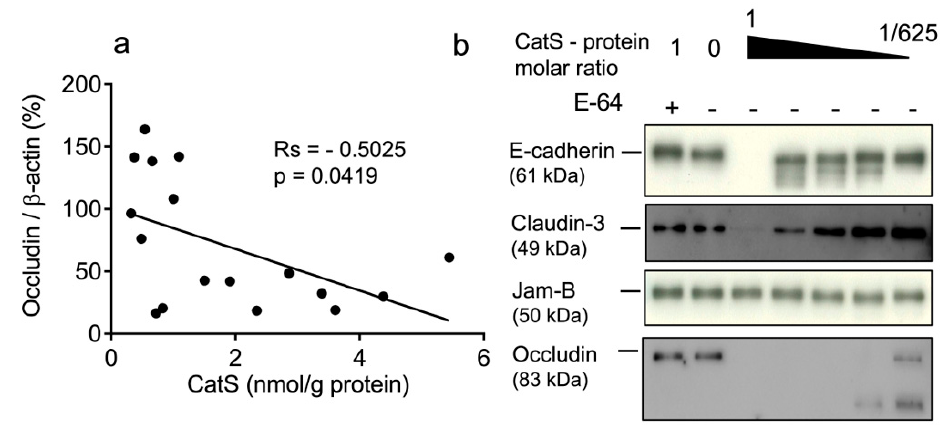
Figure 2. CatS activity negatively correlated with immunoreactive occludin level. ( a ): Correlation between CatS activity and occludin level in lung tissue lysates. Correlation was determined by linear regression and indicated by Spearman coefficient (Rs) and levels of significance ( p ). ( b ): in vitro hydrolysis of human recombinant E-cadherin, claudin-3, JAM-B, and occludin by CatS. Constant amount of junction proteins was incubated with CatS (molar ratio: 1:625 to 1:1) and incubated for 1 h at 37 °C in cell culture medium before their hydrolysis products were revealed by immunoblotting.